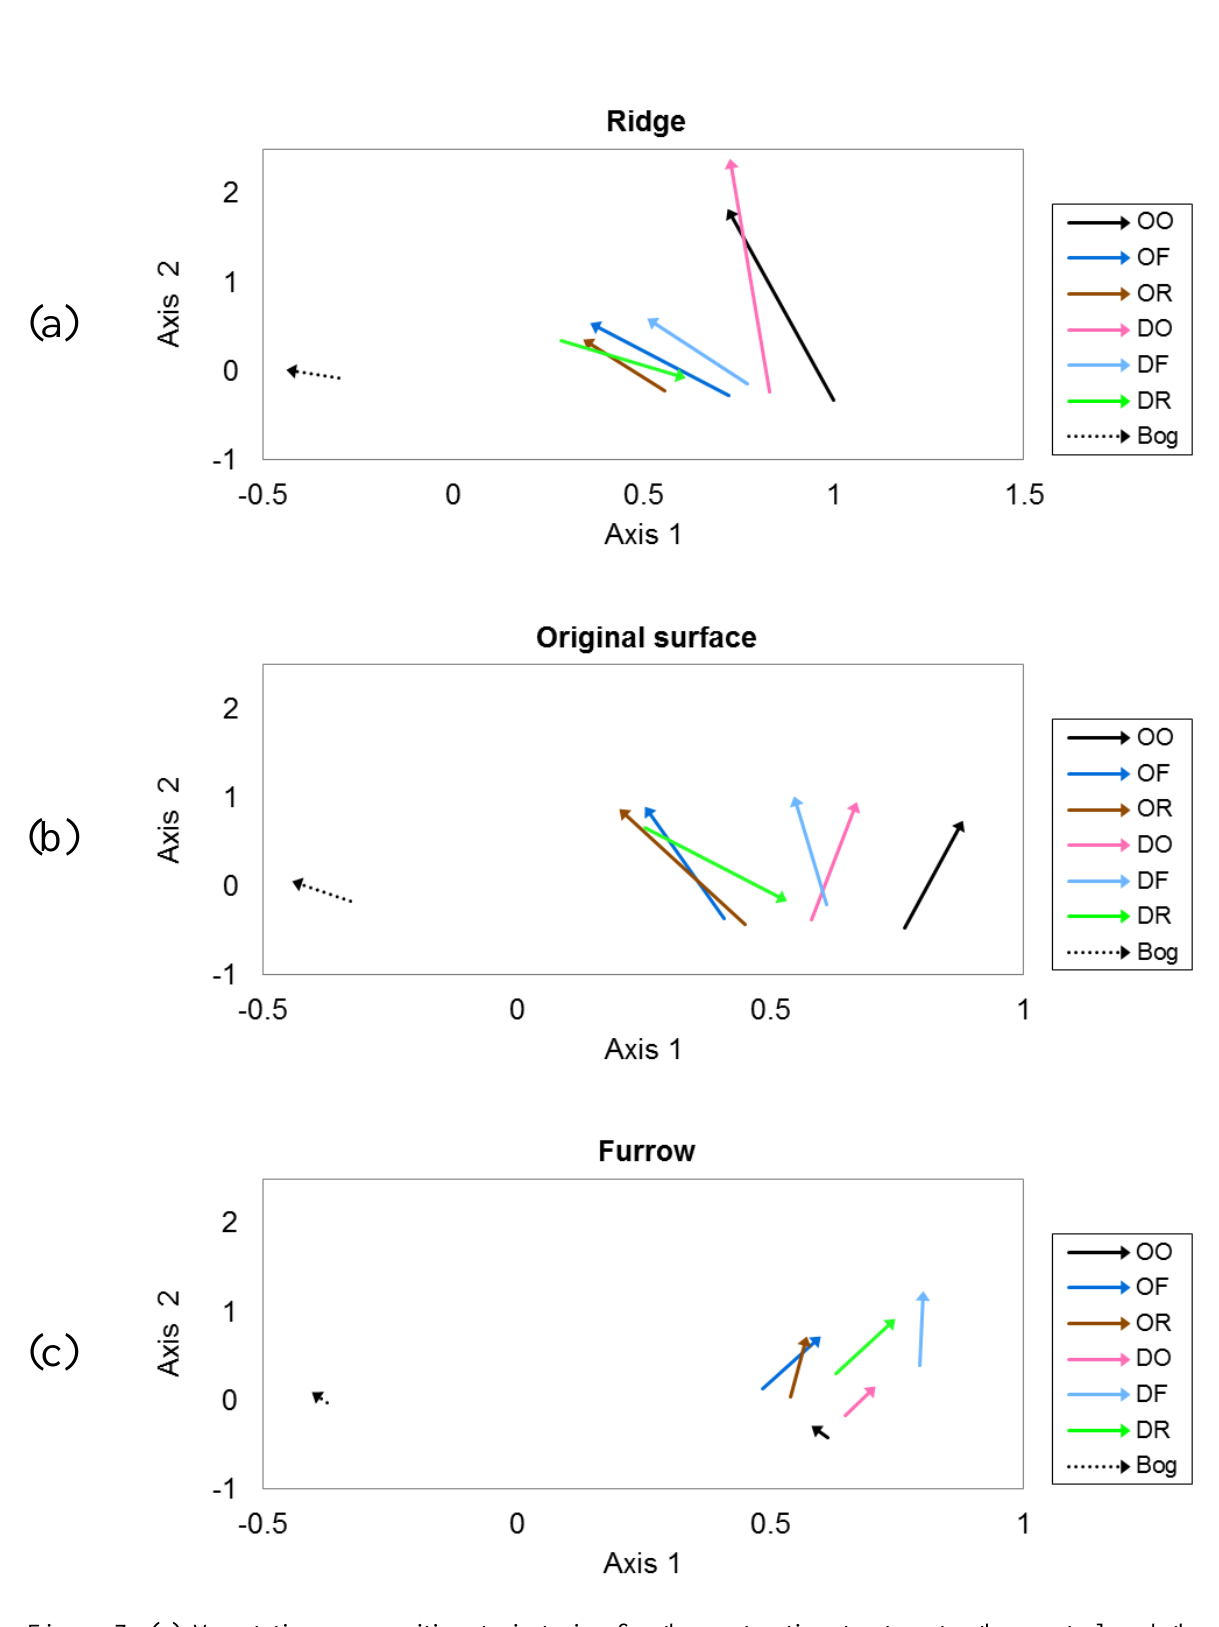
Figure 7. (a) Vegetation composition trajectories for the restoration treatments, the control and the undisturbed bog reference areas. (a) Plough ridges, (b) the original surface and (c) plough furrows. These represent the change between Year 1 and Year 10, with the arrow showing the direction of